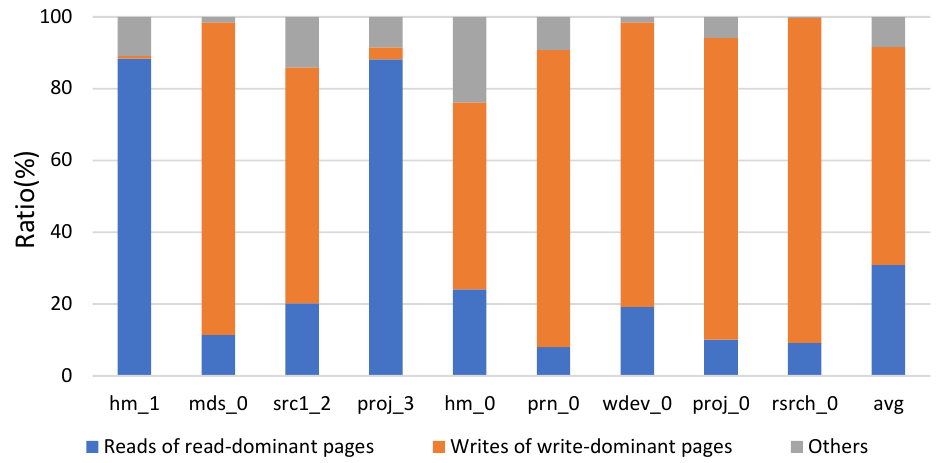
Figure 3. Distribution of reads and writes ratio processed by pages classified into three